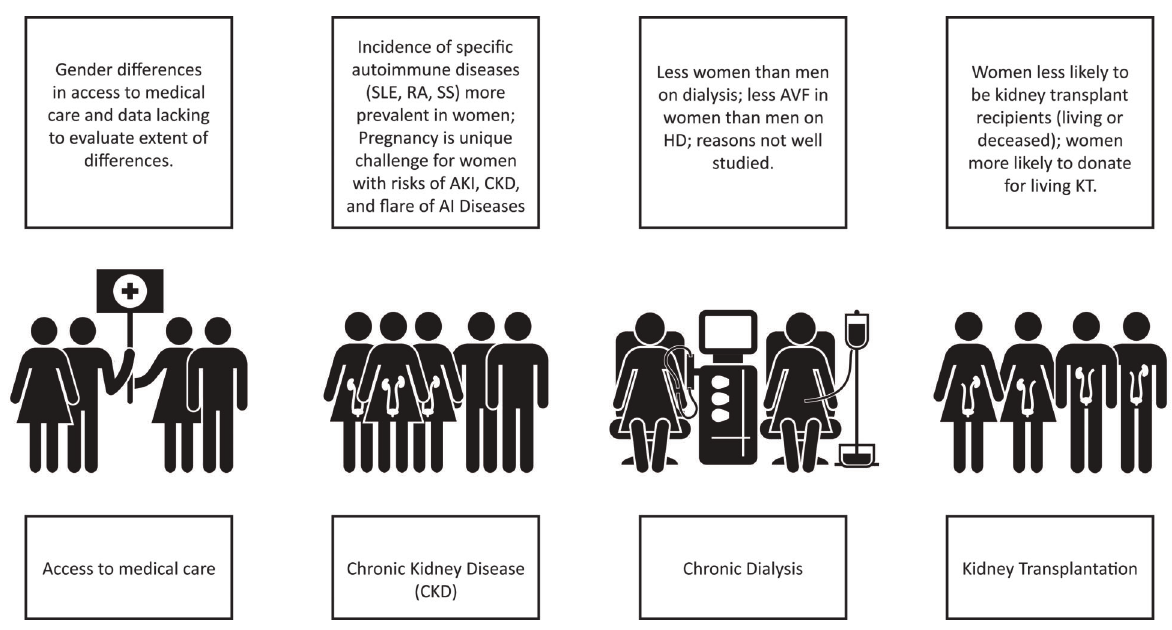
Figure 1. Gender differences throughout the continuum of chronic kidney disease (CKD) care. SLE: systemic lupus erythematosus; RA: rheumatoid arthritis; SS: Systemic Scleroderma; AKI: acute kidney injury; AI: autoimmune; AVF: arteriovenous fi stula; HD: hemodialysis; KT: kidney